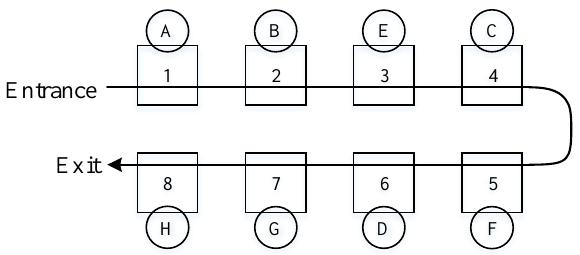
Figure 3. A feasible assignment of tasks to locations.